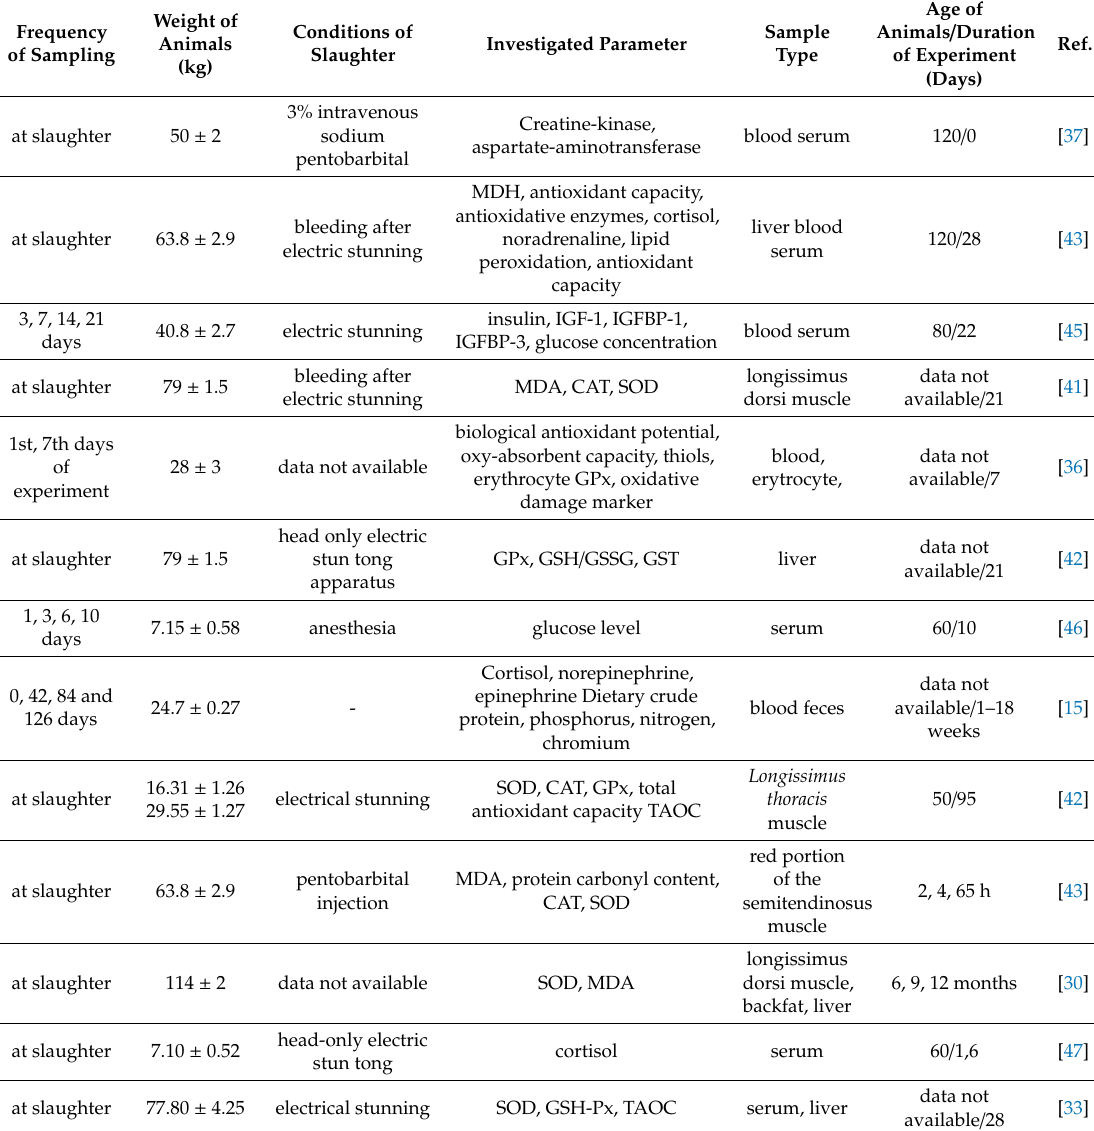
Table 1. Sampling for heat stress (HS)-related investigation of the antioxidative system and metabolites. Frequency of